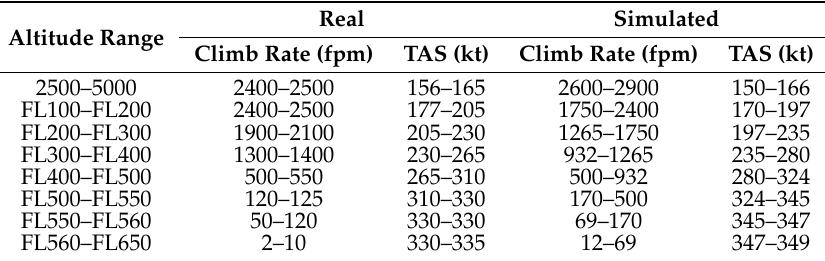
Table 7. Global Hawk cruise speed and climb rates for the real and simulated RQ-4A.